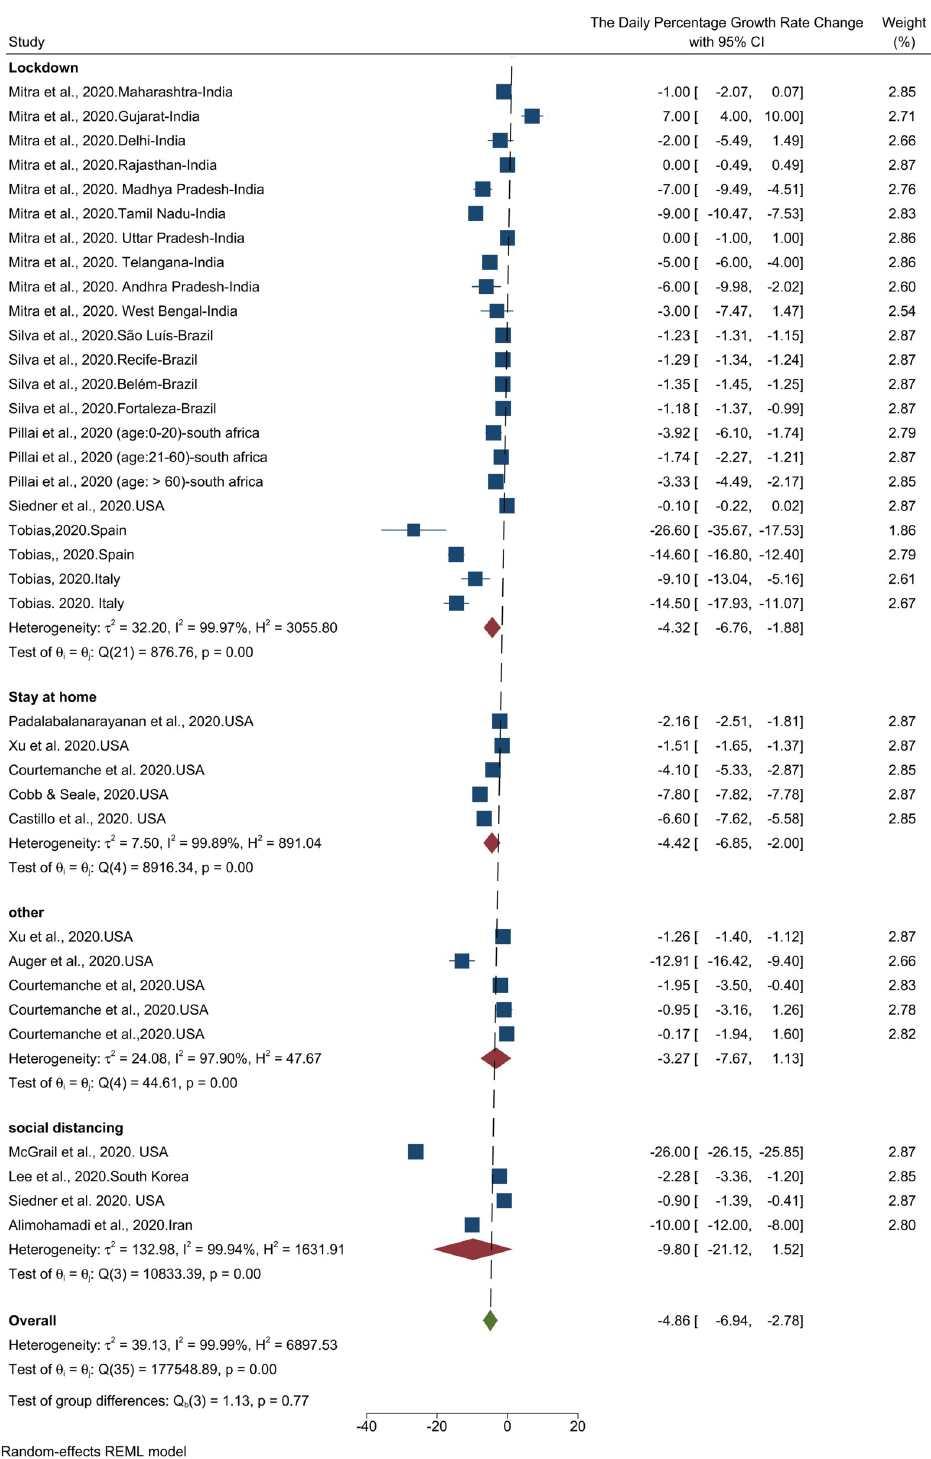
Fig 2. Results of the meta-analysis of the effects of NPHIs on the percentage changes of the COVID-19 daily case growth rate in communities based on a random effect model.